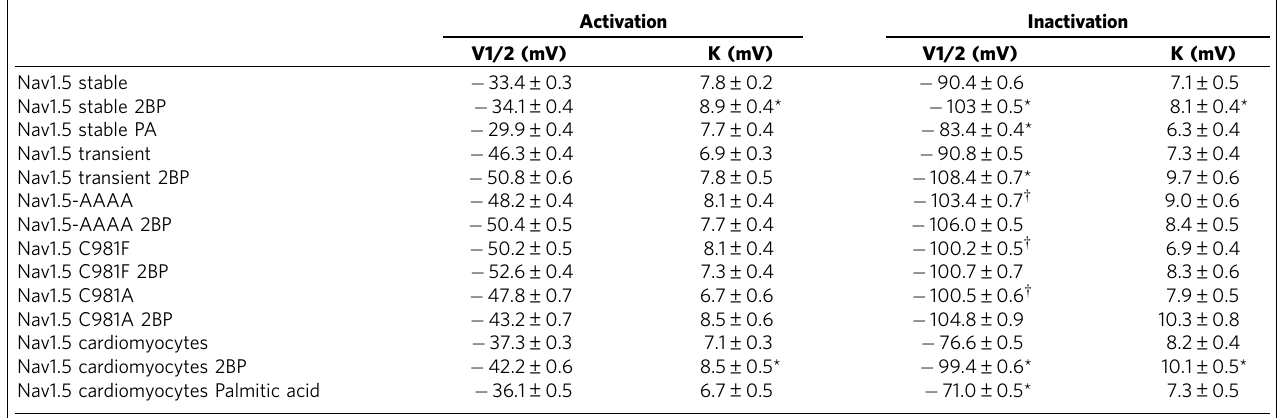
*indicates P o 0.05 compared with the corresponding non-treatment group. The two-tailed, Student’s t -test was used to study the statistical significance. w indicates P o 0.05 compared with wild-type group. All data are shown as mean ± s.e.m.